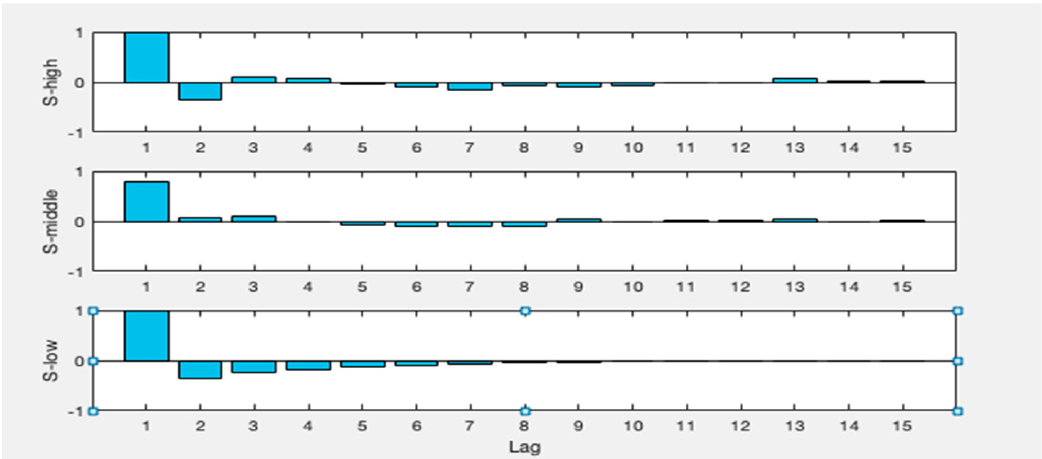
Figure 18. The PACF results of A1 by EWT of “front flat line 95.”